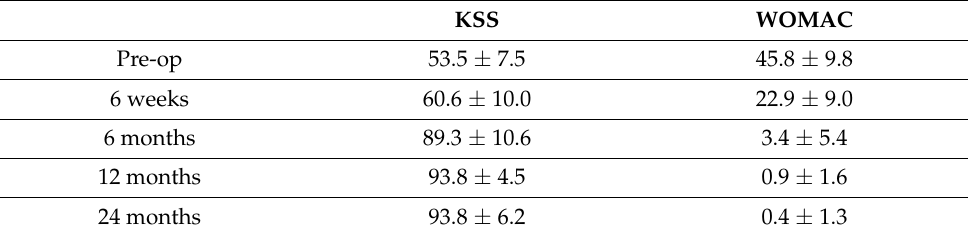
Table 1. Patient-reported outcome measures: Western Ontario and McMaster Universities Osteoarthri- tis Index (WOMAC) and Knee Society Score (KSS). Values are presented as mean ± standard deviation.